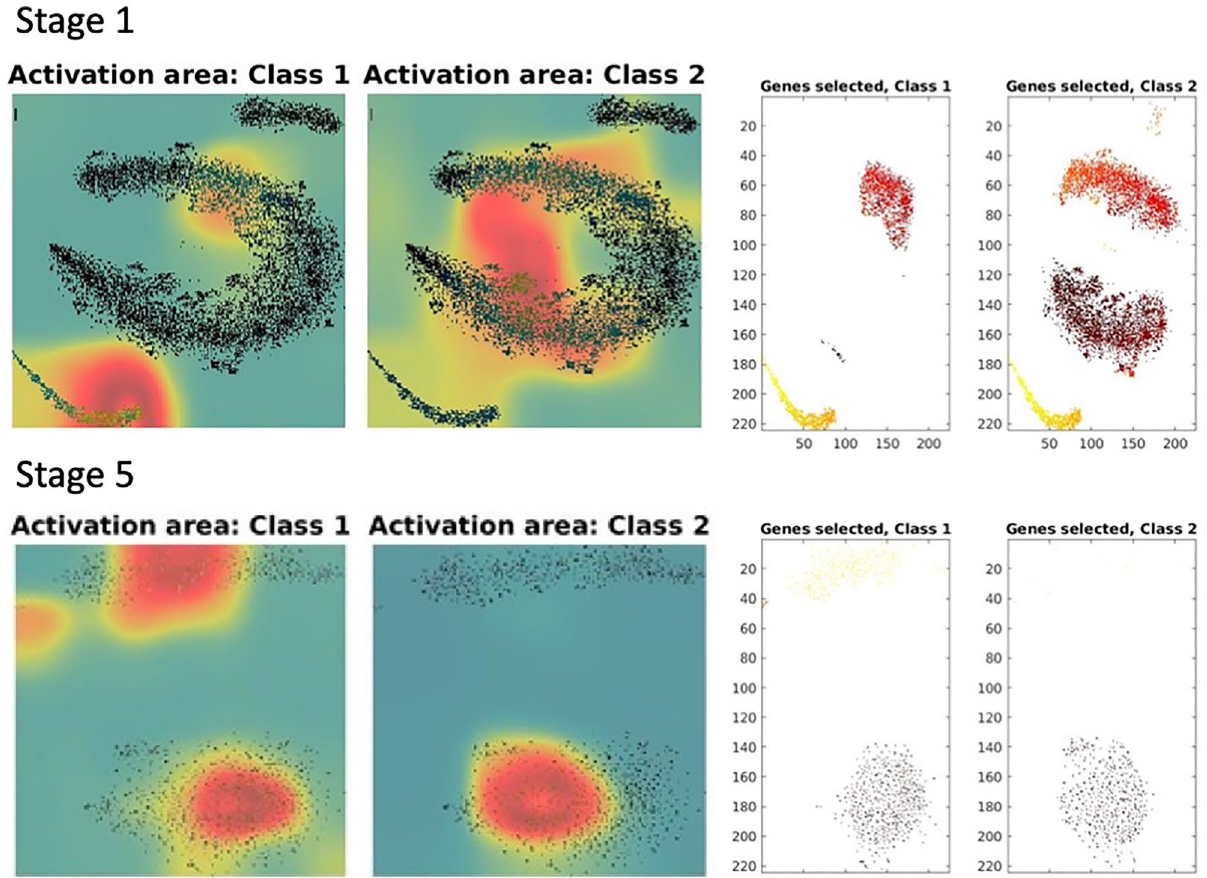
Figure 2. Activations and gene selection on Paclitaxel at Stage 1 and Stage 5. Class 1 is non-respondents and Class 2 is respondents. The left side of the figure depicts the activations in Class 1 and Class 2, and the right side illustrates the selected genes in the respective